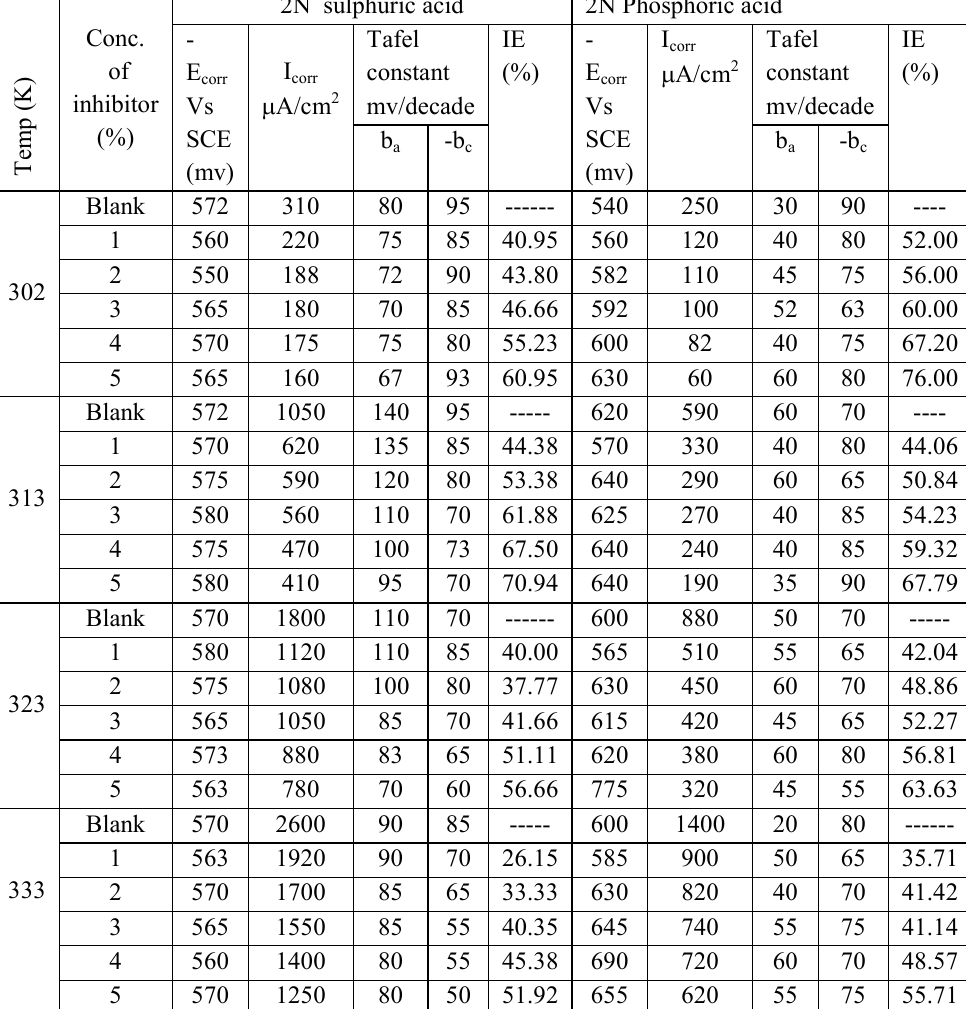
Table 3. Polarization parameters for the corrosion behaviour of mild steel in 2N sulphuric acid and 2N phosphoric acid with and without